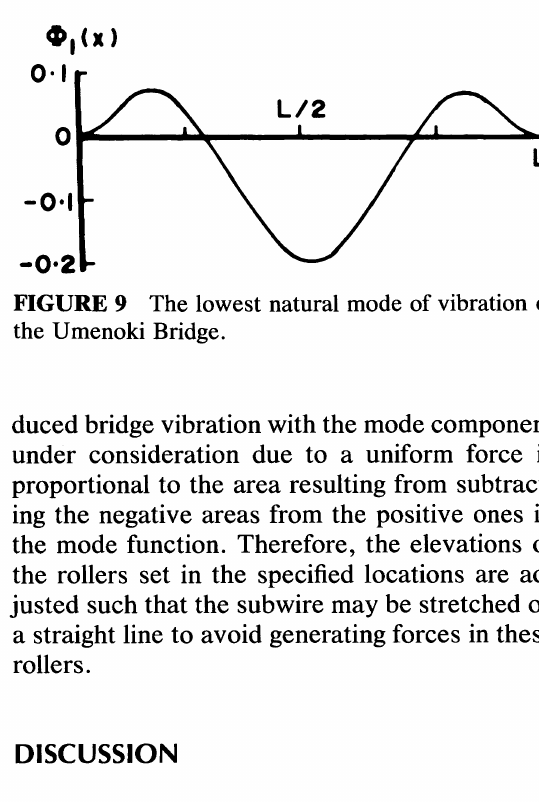
FIGURE 9 The lowest natural mode of vibration of the Umenoki Bridge.